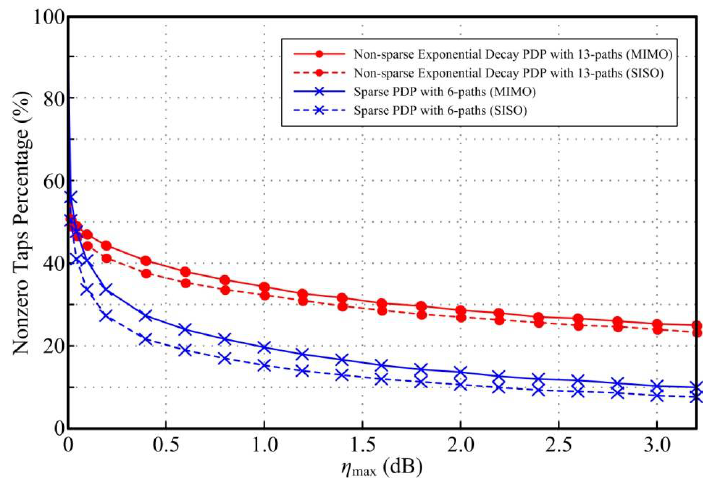
Figure 1. N onzero taps percentage for the sparse SISO DFEs and MIMO DFEs versus max η Figure 1. Nonzero taps percentage for the sparse SISO DFEs and MIMO DFEs versus η max with with SNR = 20 dB and N f = 30. SNR = 20 dB and N f =